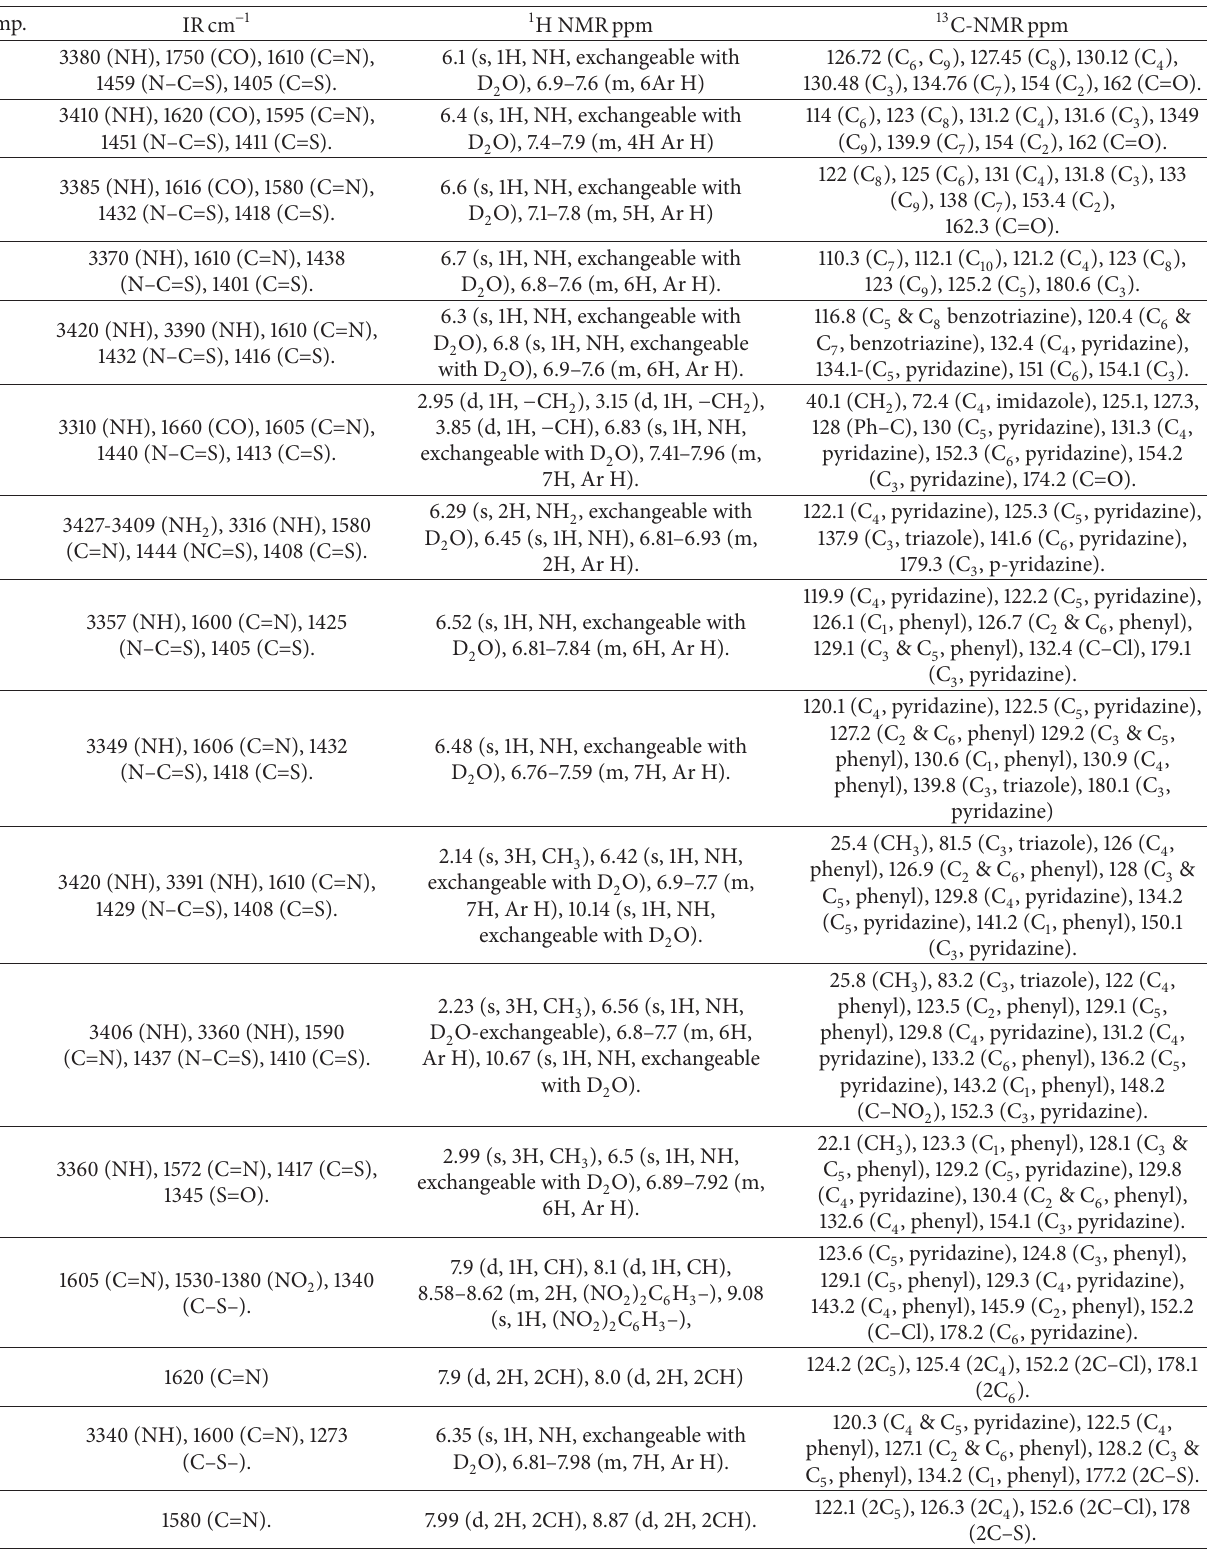
Table 3: Spectral data of compounds ( 2 – 13